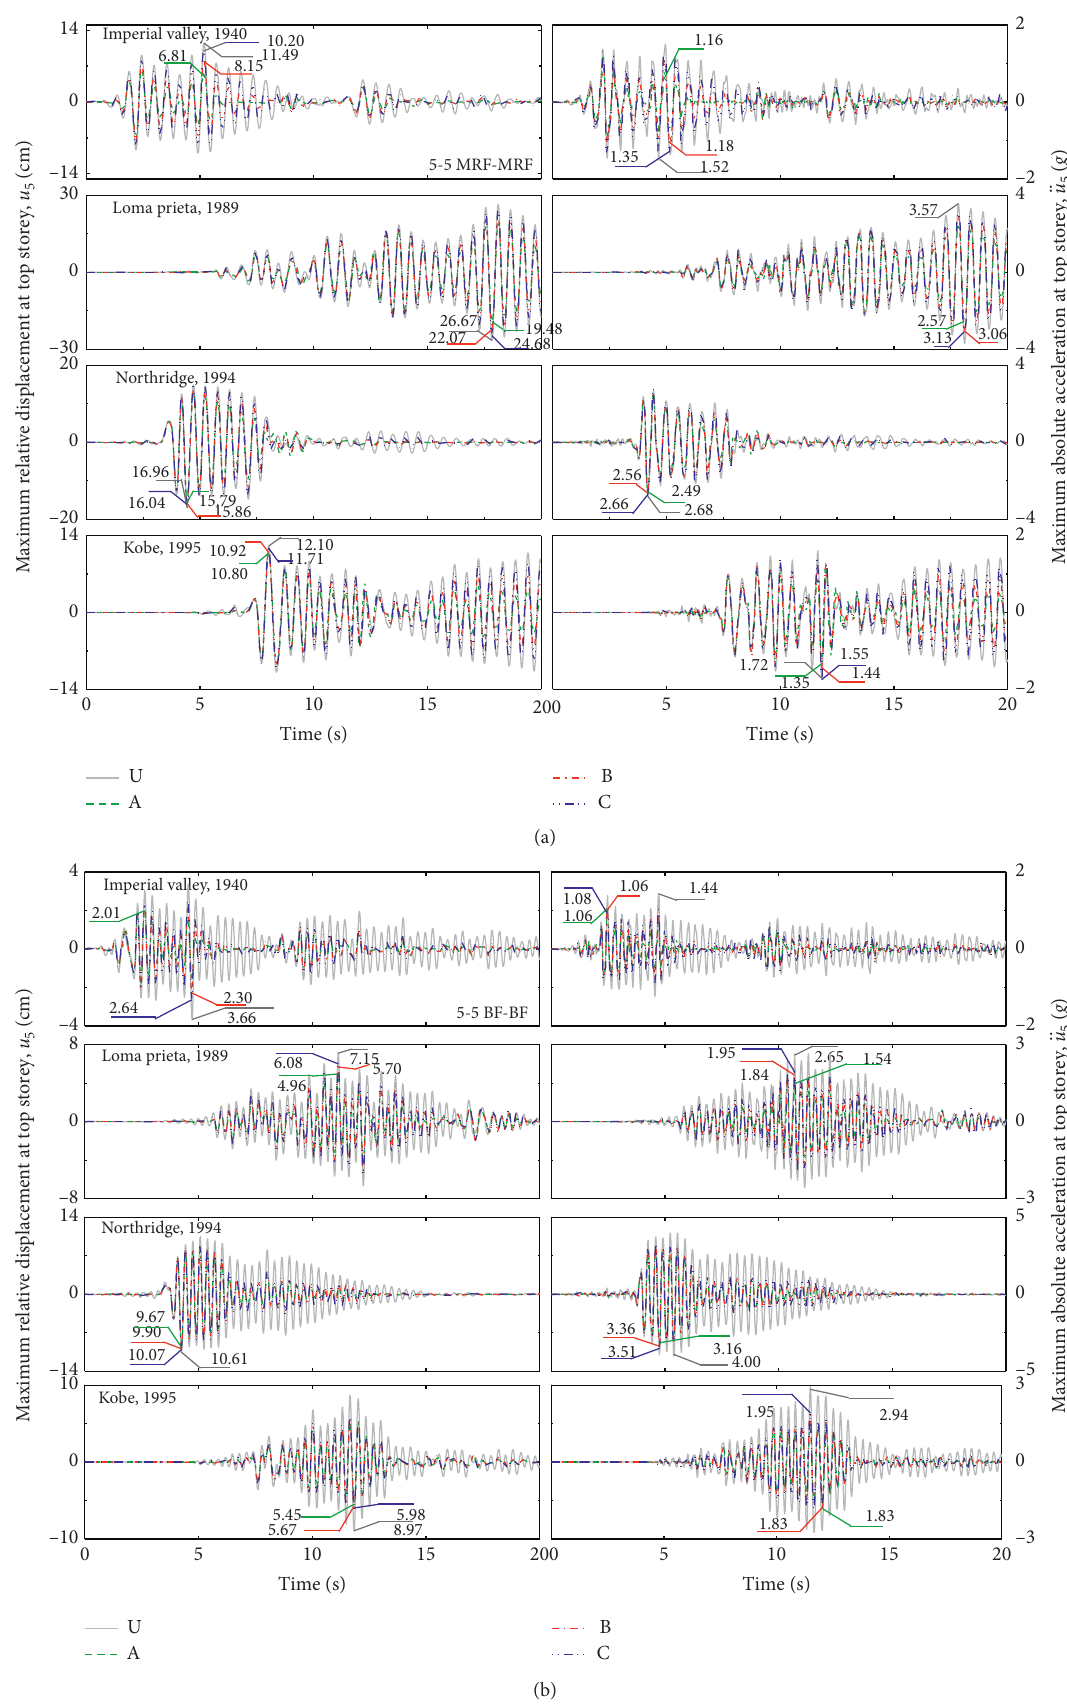
Figure 6: (a) Time history response of top floor displacement and acceleration of connected steel 5-5 MRF-MRF buildings under different earthquake ground motions. (b) Time history response of top floor displacement and acceleration of connected steel 5-5 BF-BF buildings under different earthquake ground